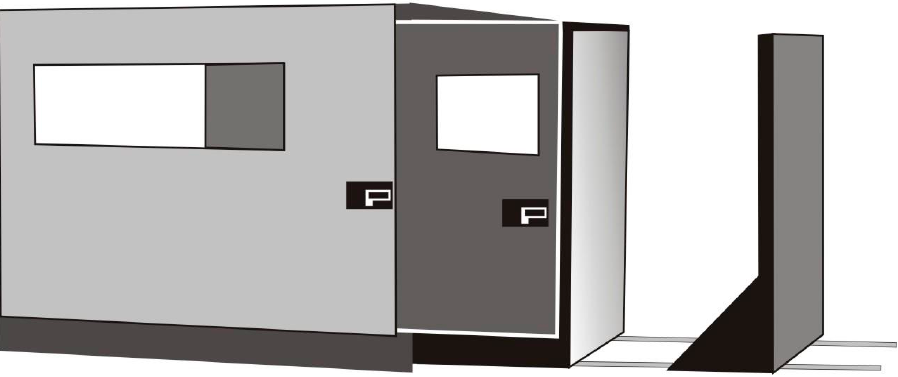
Figure 4. Soundproof cabin with telescopic design.